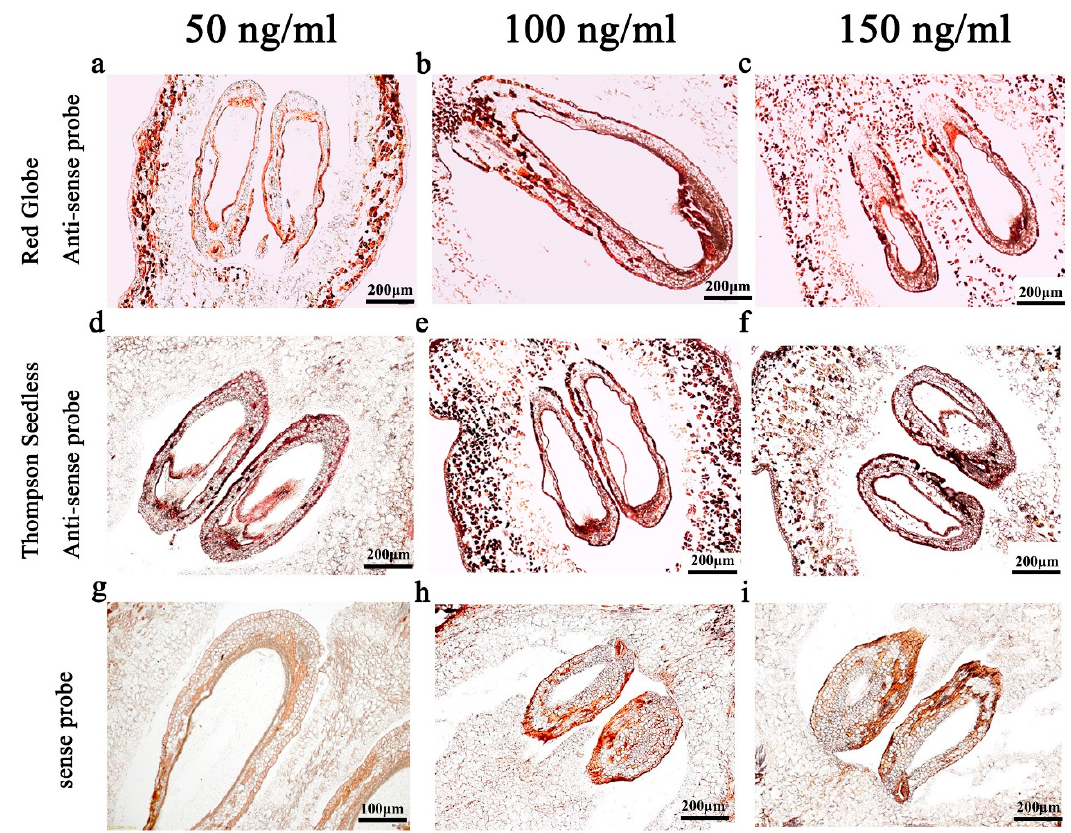
Figure 3. In situ hybridisation with different probe concentrations. The concentrations of the probe used were 50 ng/mL ( a , d , g ), 100 ng/mL ( b , e , h ) and 150 ng/mL ( c , f , i ). ( a – c ): antisense probe, 10 DAF in ‘Red Globe’; ( d , f ): antisense probe, 10 DAF in ‘Thompson Seedless’; ( g – i ): sense probe. DAF: days after flowering.